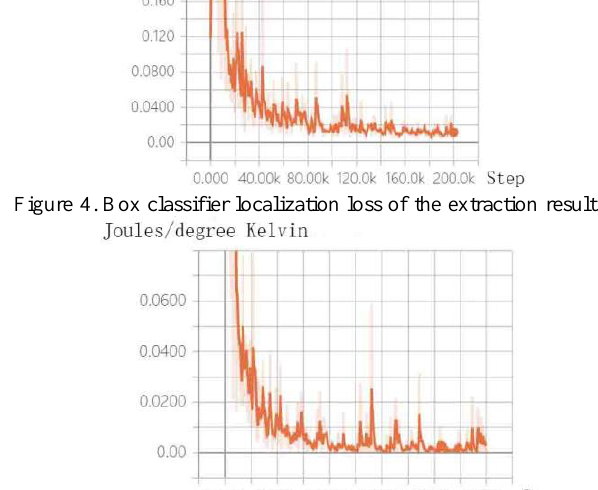
Figure 5. Region proposal network objectness loss of the extraction result